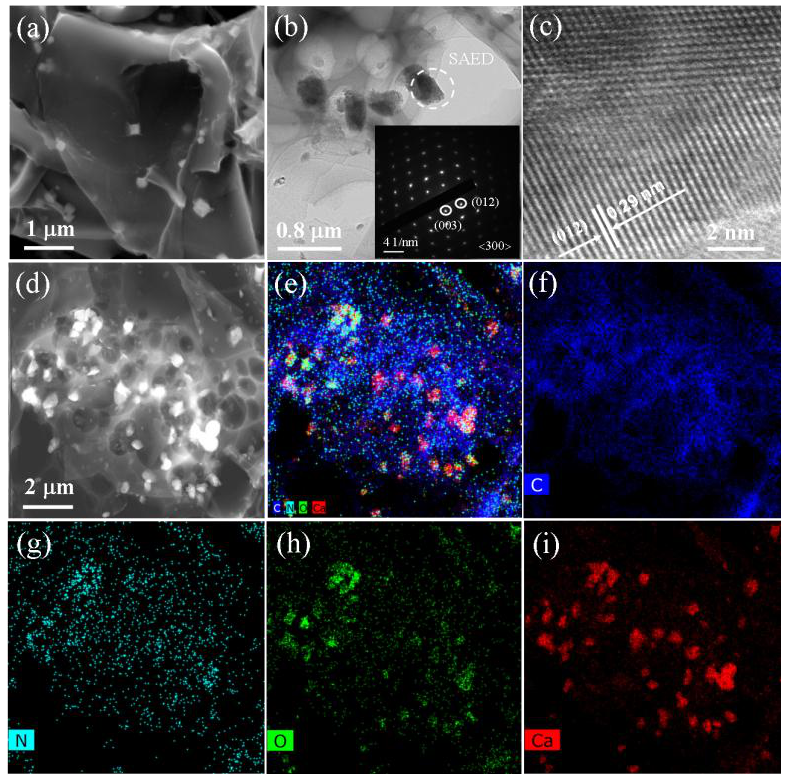
Figure 1. (a) Scanning electron microscopy, (b) transmission electron microscopy and the Figure 1. ( a ) Scanning electron microscopy, ( b ) transmission electron microscopy and the selected-area electron di ff raction (inset), ( c ) high resolution transmission electron microscopy, ( d ) high-angle selected-area electron diffraction (inset), (c) high resolution transmission electron microscopy, (d) annular dark-field scanning transmission electron microscopy images and (e–i) elemental mapping high-angle annular dark-field scanning transmission electron microscopy images and (e–i) of elemental mapping of PDRC-1000.